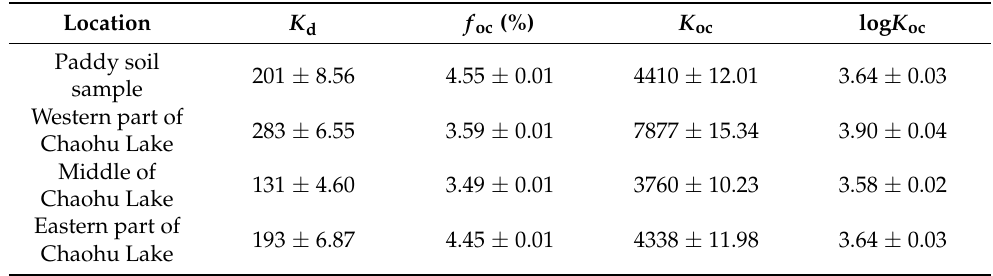
Table 6. The K d and log K oc values of 2,3,7,8-TCDT in sediments from Chaohu Lake and paddy